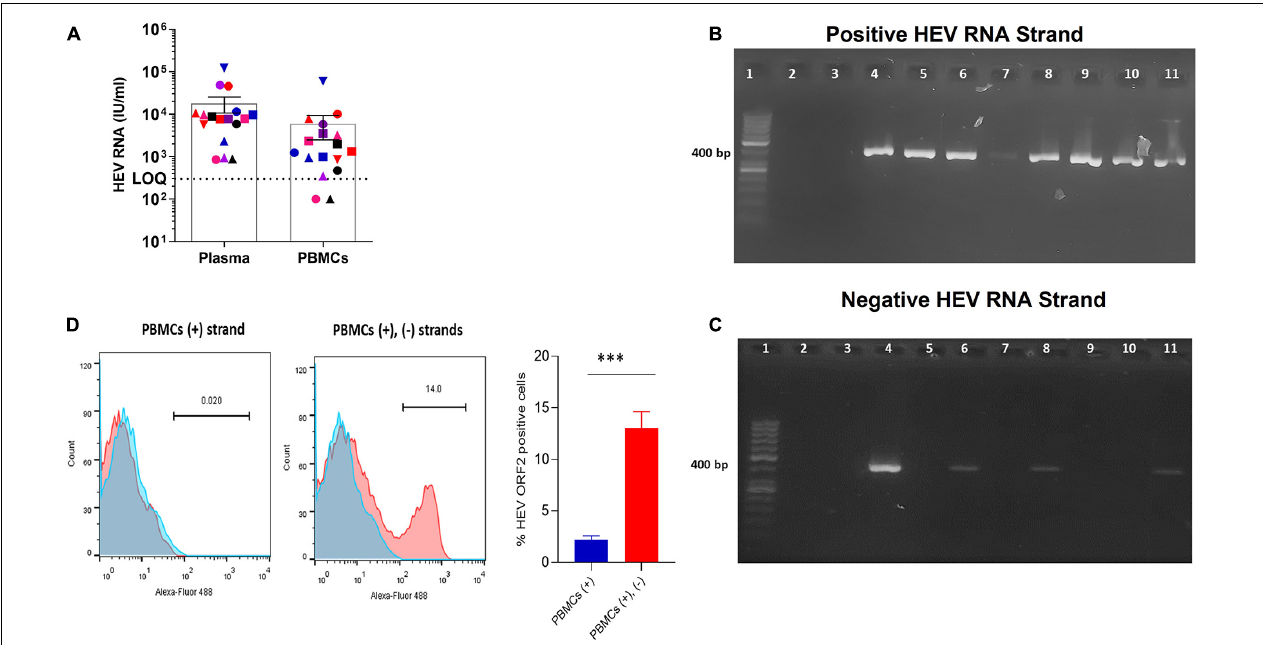
FIGURE 1 | Assessment of the viral load in PBMCs of AHE patients and detection of ( + ) and (–) RNA strands. (A) HEV RNA was quantified in the plasma and PBMCs from AHE patients ( n = 17). Different colors and symbols represent different patients. The same color and symbol in the different groups ( x -axis) indicate the same patient. LOQ: limit of quantification. (B,C) Representative gel showing the detection of strand-specific ( + ) HEV RNA strand (B) and (–) HEV RNA strand (C) in the PBMCs of AHE patients using strand-specific nested PCR targeting HEV ORF1. Lanes 6–11 (B,C) show strand-specific RT PCR for the following patients: pt#17 (lane 6), pt#12 (lane 7), pt#11 (lane 8), pt# 10 (lane 9), pt#9 (lane 10), pt#1 (lane 11). Lane 3 in (B,C) represents non-template control (negative controls for both assays). Lane (4) in (B,C) represents RNA extracted from primary human monocytes infected with HEV-1 in vitro, which is a positive control for both ( + ), and (–) HEV RNA strands using strand-specific primers for each strand. Lane (5) in (B,C) represents RNA extracted from the plasma of pt#17, which serves as a positive control for ( + ) RNA strand and negative control form (–) RNA strand. Lane 1 shows a 50-bp DNA ladder. Lane 2 in (B,C) : left empty. (D) Representative gating showing the detection of the HEV ORF2 protein in the PBMCs of AHE patients. Blue histograms represent cells treated with the secondary A488 anti-mouse antibodies, and red histograms represent cells stained by the mouse anti-HEV-ORF2 followed by the secondary A488 anti-mouse antibodies. (Left) Expression of HEV ORF2 protein in the PBMCs with detectable ( + ) HEV RNA strand only (pt # 12). (Middle) Expression of HEV ORF2 protein in the PBMCs with detectable ( + ), (–) HEV RNA strands (pt # 1). (Right) Percentage of HEV ORF2 positive cells from PBMCs with detectable ( + ) HEV strand only ( n = 10) and PBMCs with detectable ( + ), and (–) HEV RNA strands ( n = 4). Error bar represents mean ± SEM, *** p < 0.001, as determined by the unpaired t